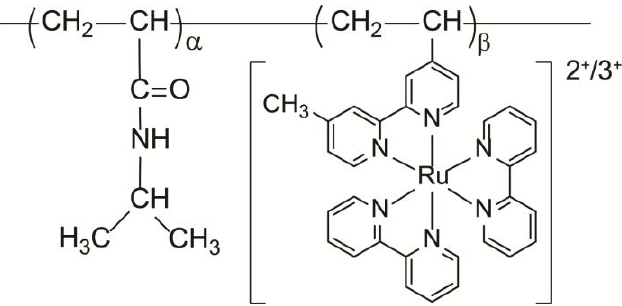
Figure 2. Chemical structure of poly(NIPAAm- co -Ru(bpy)